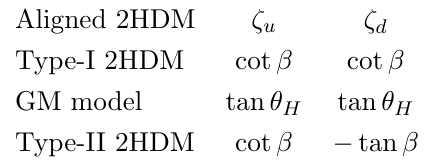
Table 1 . Charged Higgs couplings to fermions in the Aligned 2HDM, and corresponding values in the Type-I and -II 2HDMs and the GM model. The couplings are de(cid:12)ned in terms of the Feynman rule for the H + (cid:22) tb vertex, is the SM Higgs